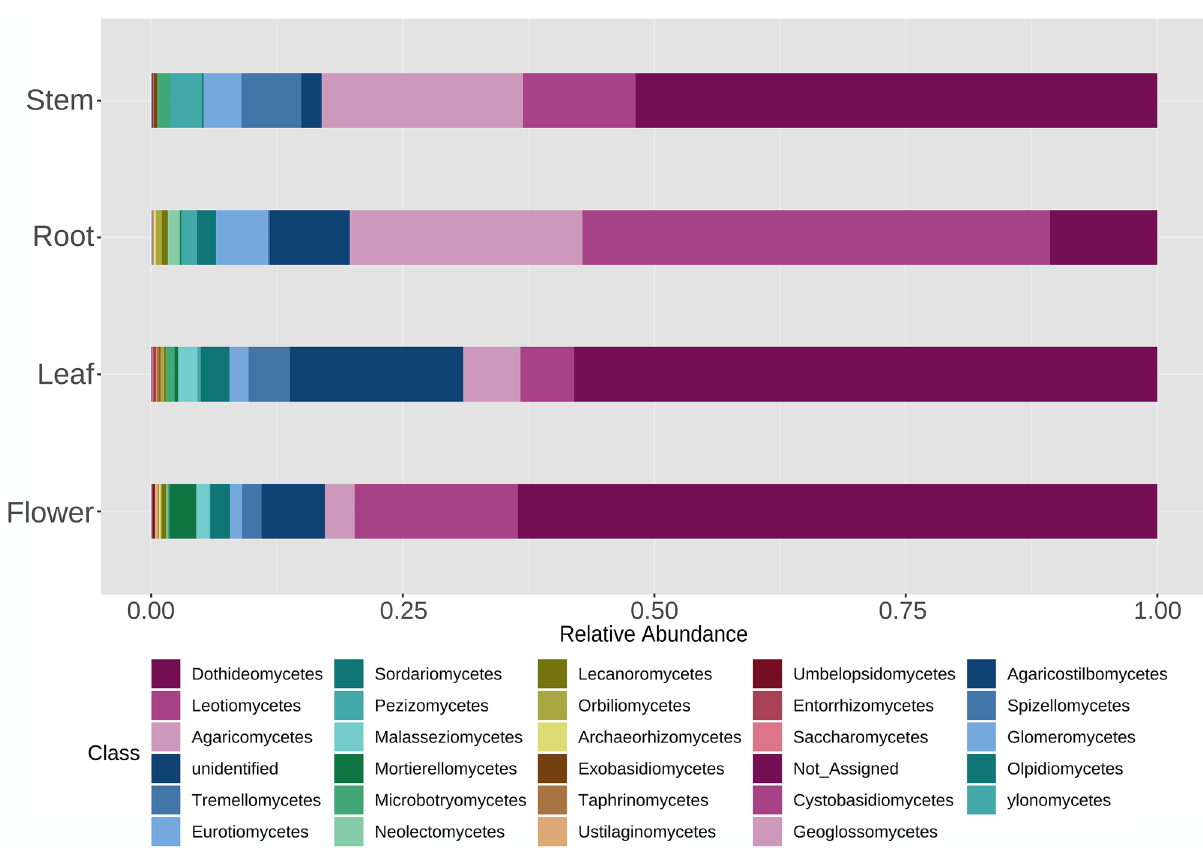
Figure 2. Description of the fungal diversity associated with different plant organs: relative abundance of fungal